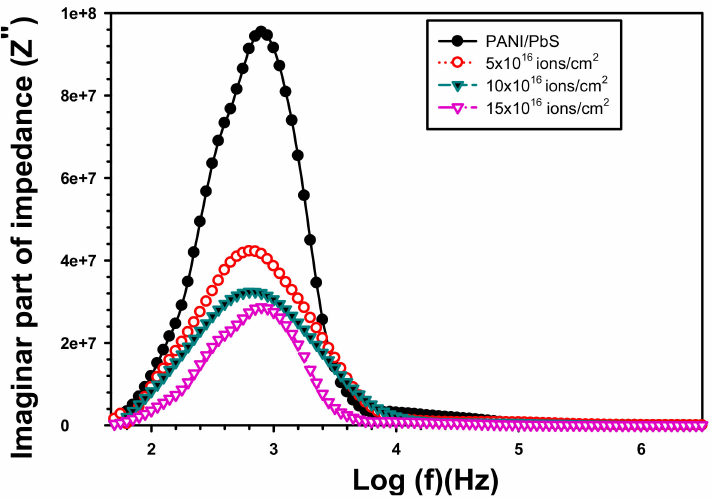
Figure 11. Imaginary impedance Z” with frequency for pristine and treated PANI/PbS.